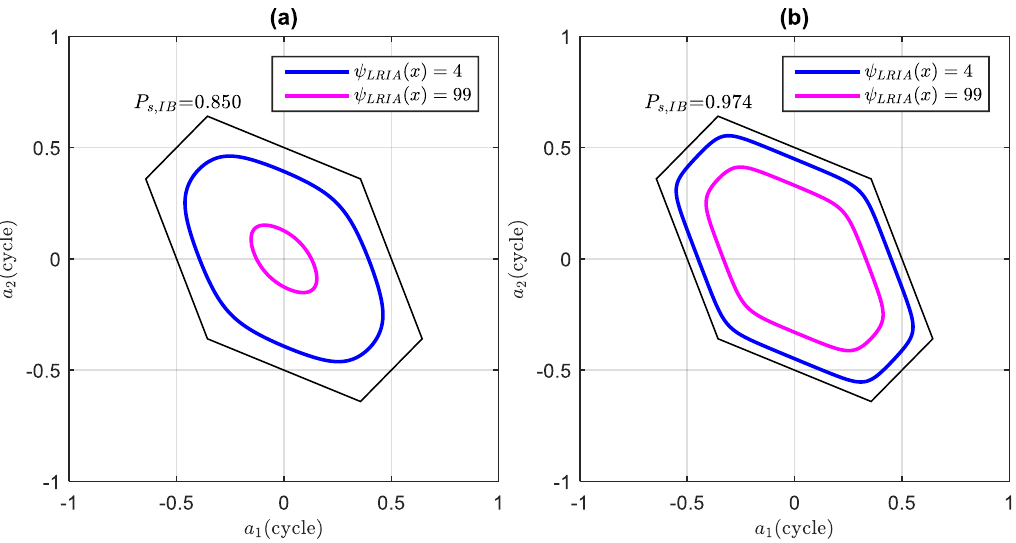
Figure 2. Illustration of two-dimensional examples of the acceptance region of the likelihood ratio integer aperture (LRIA) with different thresholds and different underlying models. ( a ): weaker underlying model ( b ): stronger underlying model.